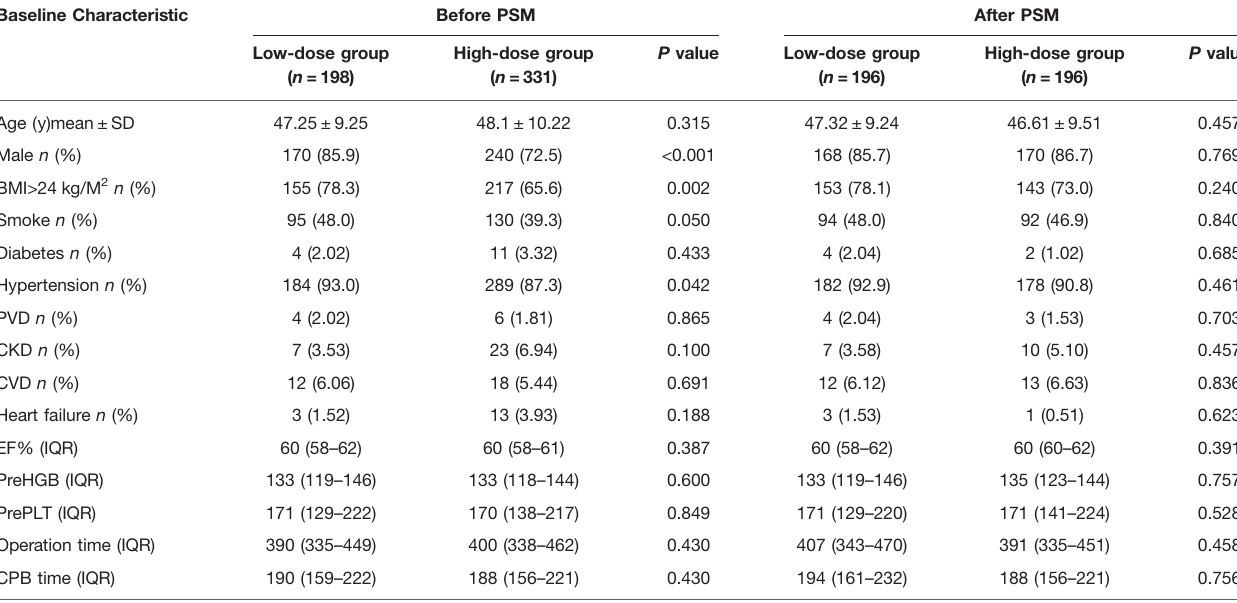
TABLE 1 | Baseline characteristics before and after PSM.